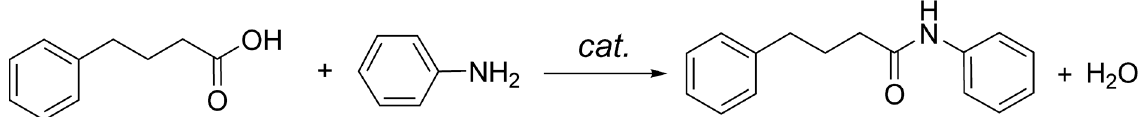
Scheme 1. The scheme of the 4, N -diphenylbutynamide synthesis.